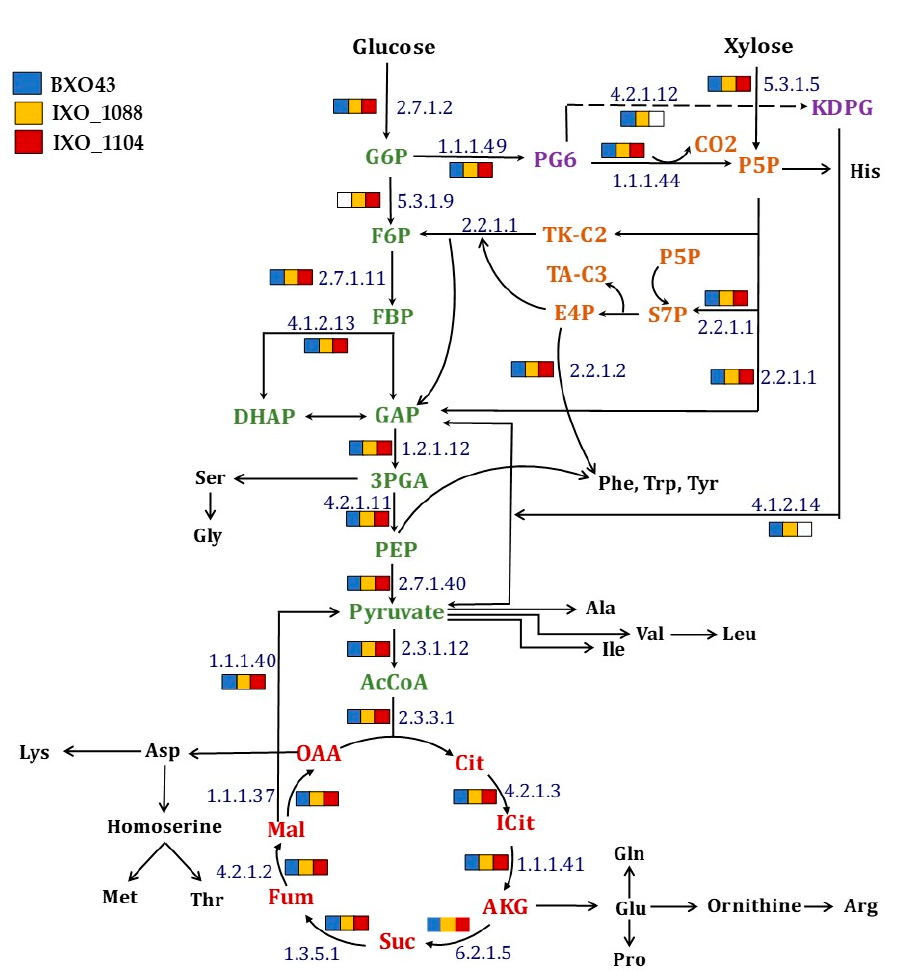
Figure 1. An overview of the simple central carbon network of the Xanthomonas oryzae pv. oryzae BXO43 strain. A KEGG mapper was used for mapping the presence and absence of any annotated enzyme throughout the metabolic pathways among the Xoo strains (see legend for color codes). The enzyme responsible at each node is represented by enzyme commission (EC) numbers. The absence of any enzyme in a strain is shown by the absence of any color. The central metabolic pathway intermediates that are responsible for various amino acids biosynthetic routes are presented. The intermediates of four major metabolic pathways, namely, Glycolysis, the Tricarboxylic acid cycle, Entner-Doudoroff and pentose phosphate pathway (simplified) are shown in green, red, violet and orange, respectively, whereas amino acids are depicted using their three-letter code in black.